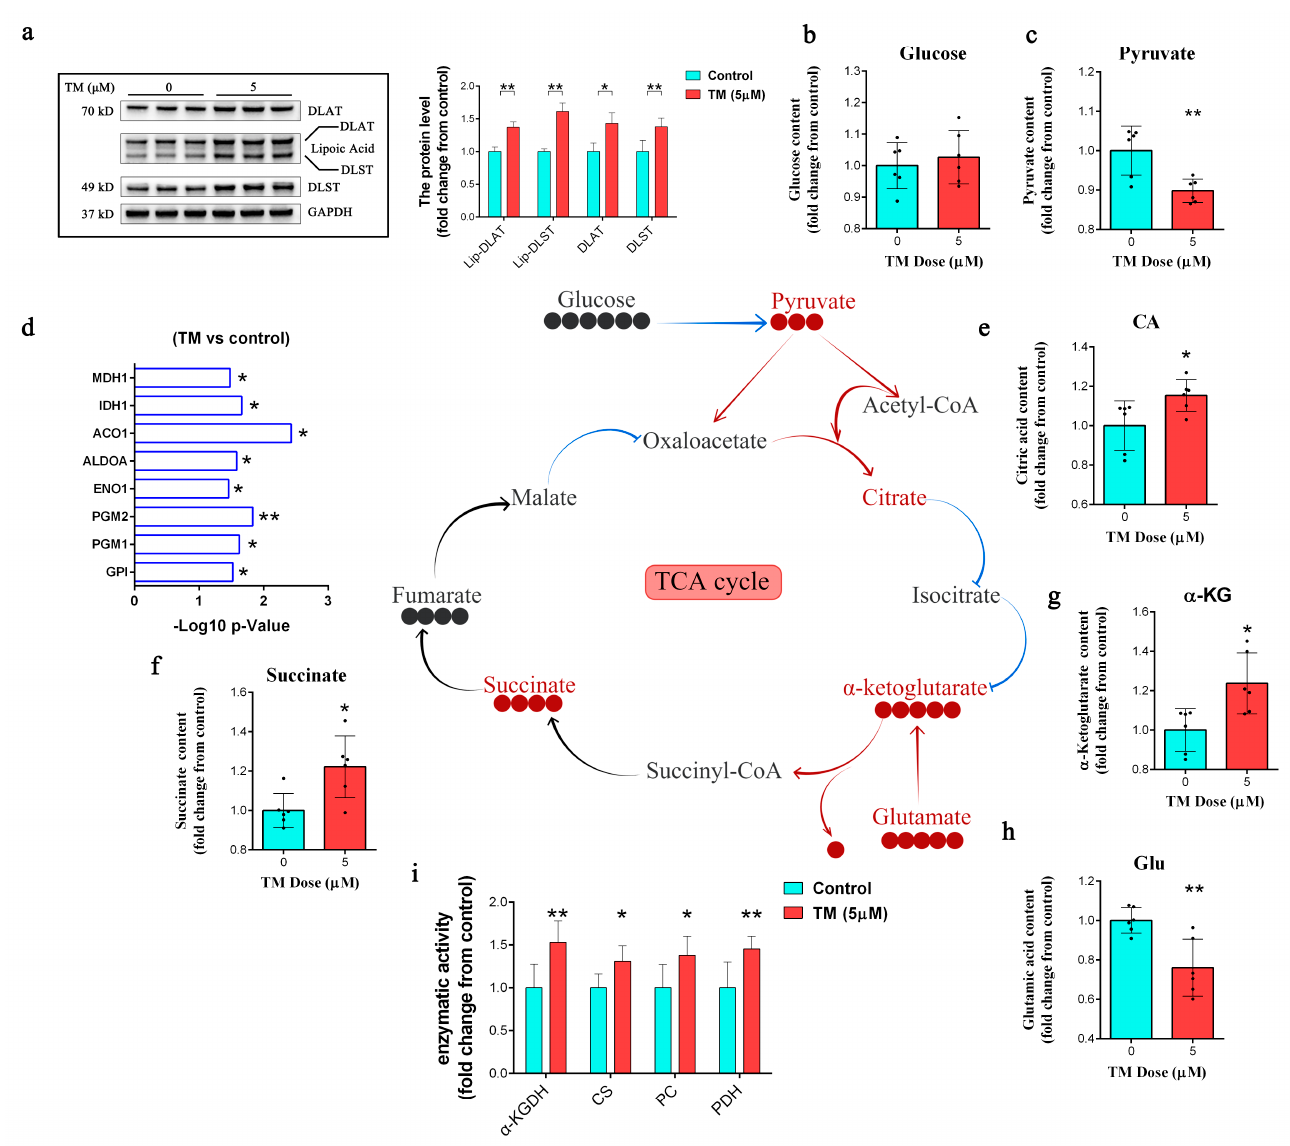
Figure 3. ( a ) Western blot analysis of the protein levels of DLAT, DLST, and lipoylated proteins after 72 h of TM (5 µM) treatment ( n = 3); * p < 0.05; ** p < 0.01. ( b , c ) Glucose and pyruvate consumption analysis after 72 h of TM (5 µM) treatment in DPCs, and the supernatant was replaced 24 h before collection in both groups ( n = 6); ** p < 0.01. ( d ) Downregulated protein analysis after 72 h of calculated using multiple t-tests ( n = 3/group); * p < 0.05, ** p < 0.01. ( e – h ) Measurement of